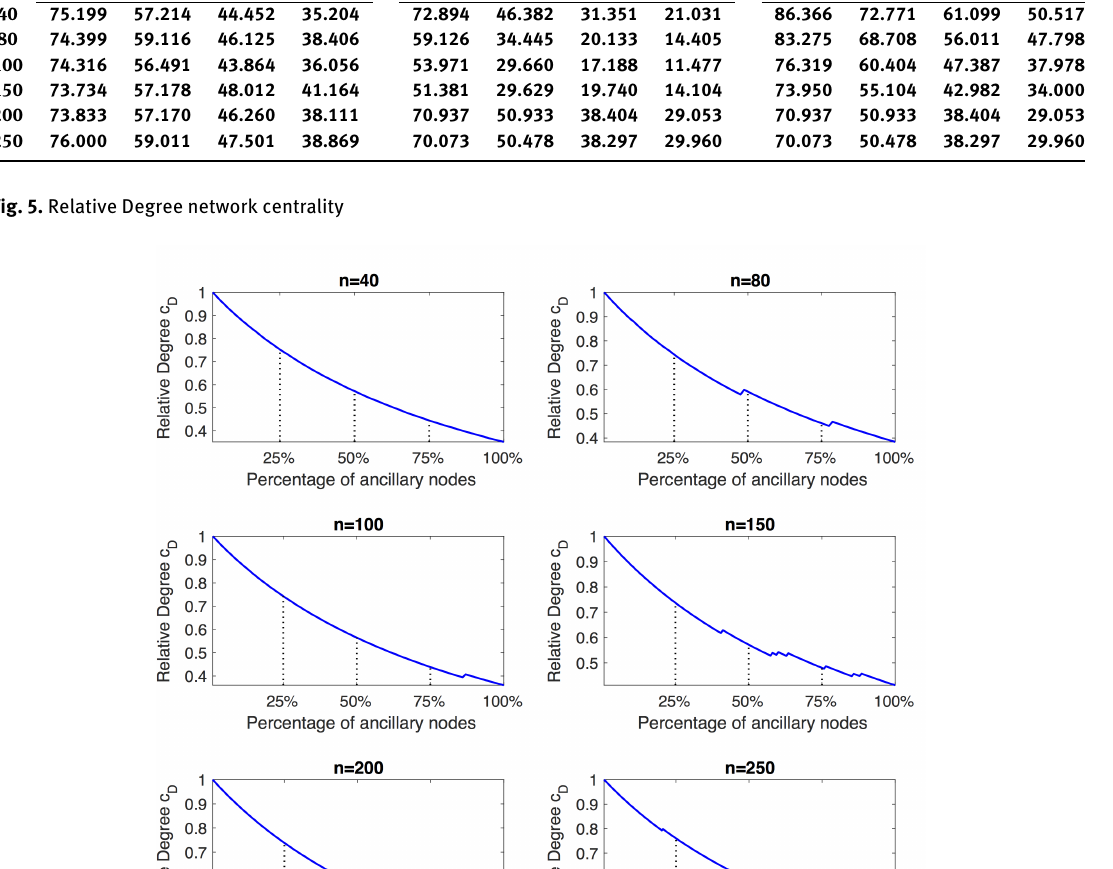
Table 2. Relative values of degree network centrality ( C D ), betweenness network centrality ( C B ) and closeness network centrality ( C ) for the original simulated networks and extended networks with 25%,50%,75% and 100% of ancillary points. C